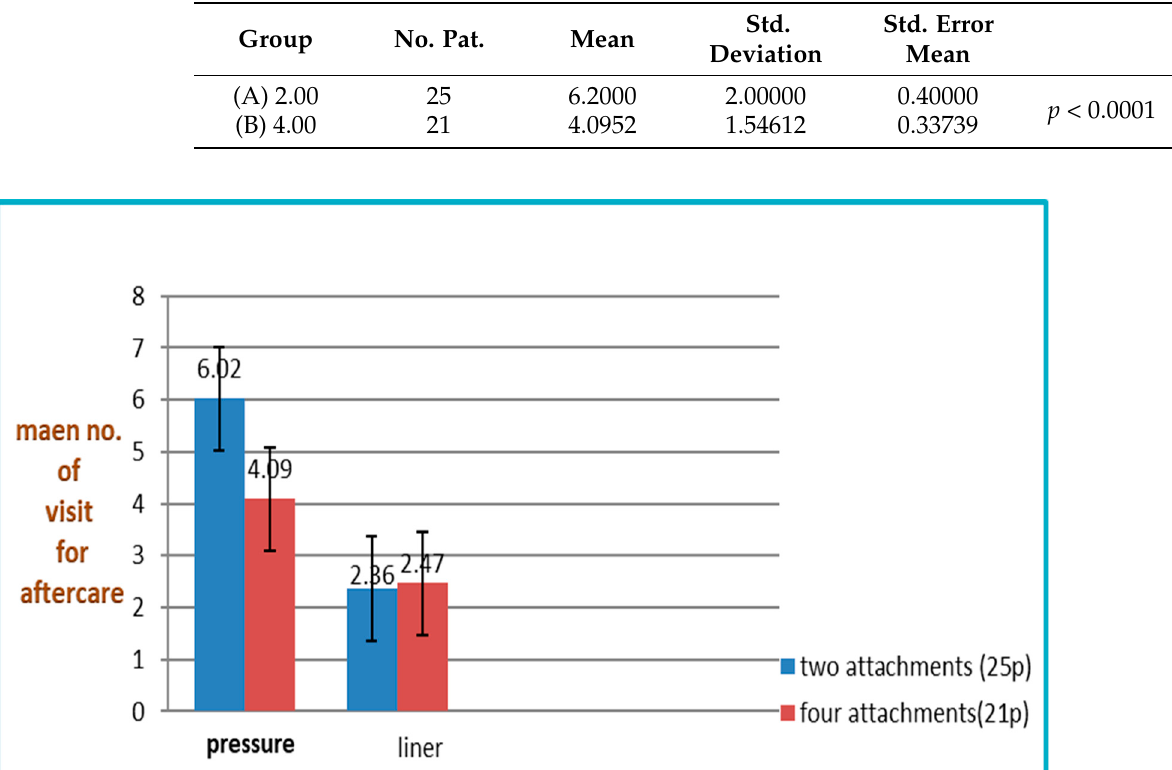
Table 2. T -test liner exchange.